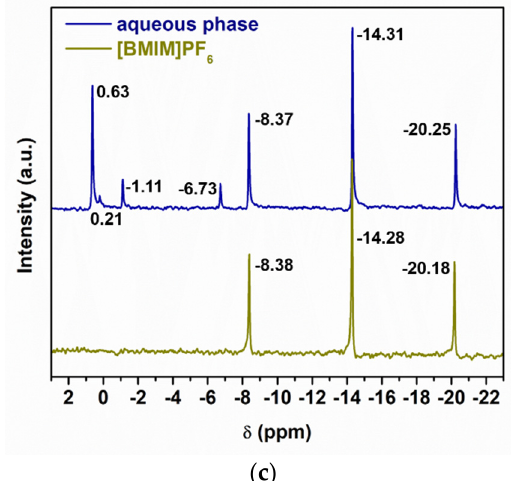
Figure 5. 31 P NMR spectra acquired in CD 3 CN or D 2 O for each [BMIM]PF 6 and aqueous phases present in the catalytic systems [Na]PMo 12 (10 th cycle; a ), [BPy]PMo 12 (10 th cycle; b ), and [BPy]PW 12 (5 th cycle; c ).